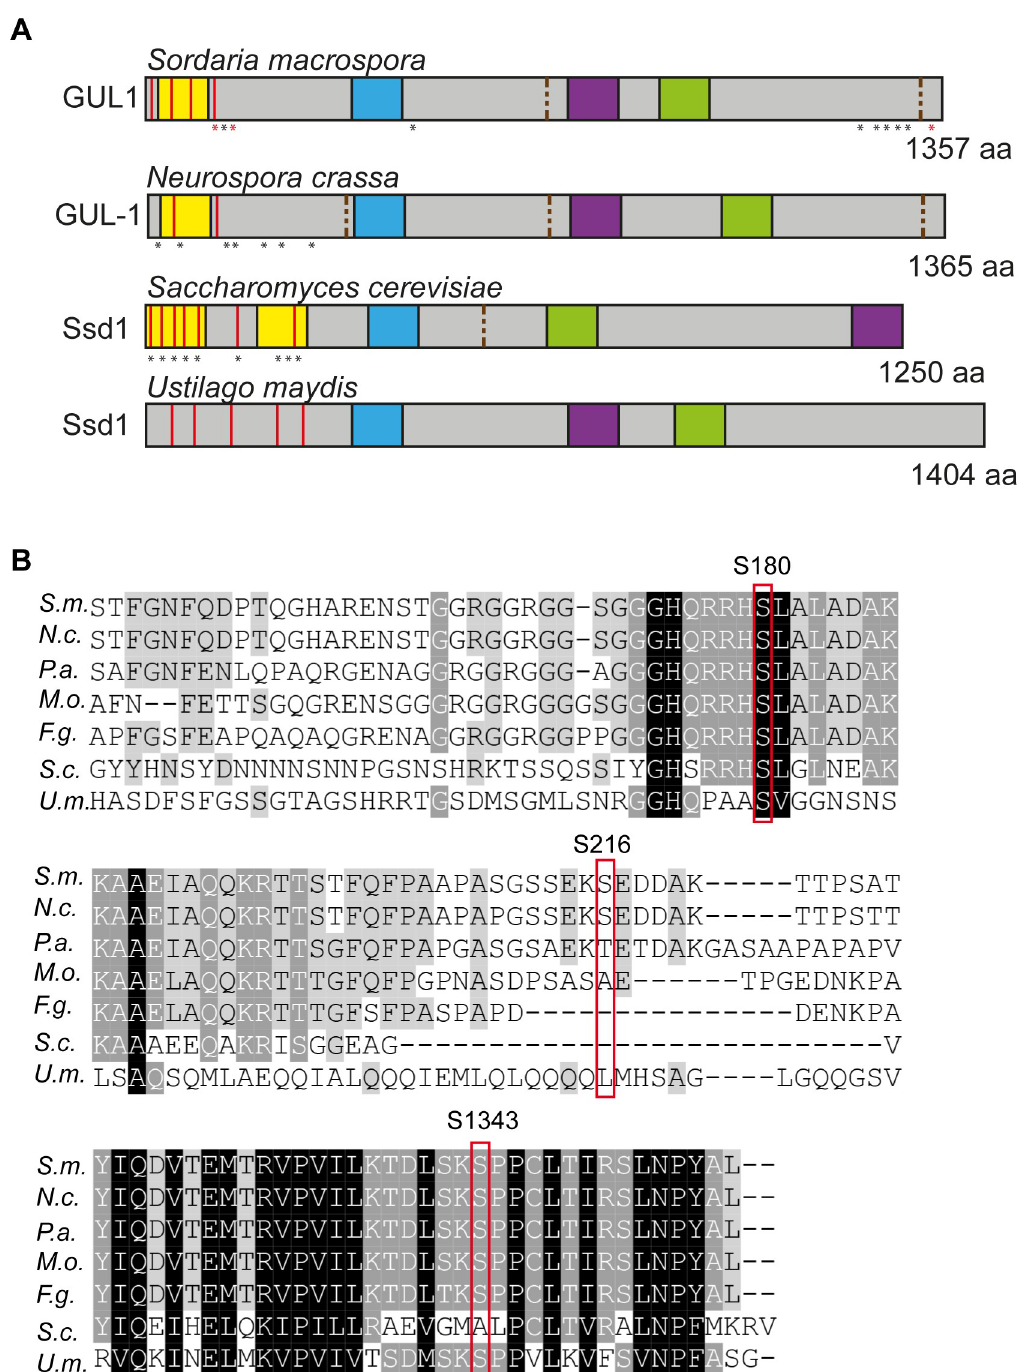
Fig 2. Primary structure and amino acid sequence of GUL1 and its homologues. (A) Identical protein domains in S . macrospora GUL1 and its homologue Ssd1 in Neurospora crassa , Saccharomyces cerevisiae and Ustilago maydis . Domains were analysed with ELM and have the following designation: yellow, Prion-like domain; red, LATS/NDR kinase recognition sites; blue, Nuclear localization signal; green, RNA binding domain; purple, nuclear export signal; brown dashed lines, PP2A- binding sites. Asterisks indicate phosphorylation sites, red asteriks in GUL1 were further investigated in this study (S180, S216, S1343). Yeast Ssd1 phosphorylation sites were adopted from Kurischko and Broach (2017). (B) Alignment of specific regions of the GUL1 protein from S . macrospora sequence with homologues from N . crassa ( N . c ., NCU01197), P . anserina ( P . a ., PODANS_2_6040), M . oryzae ( M . o ., MGG_08084), F . graminearum ( F . g ., FG05_07009), S . cerevisiae ( S . c ., SCY_1179) and U .